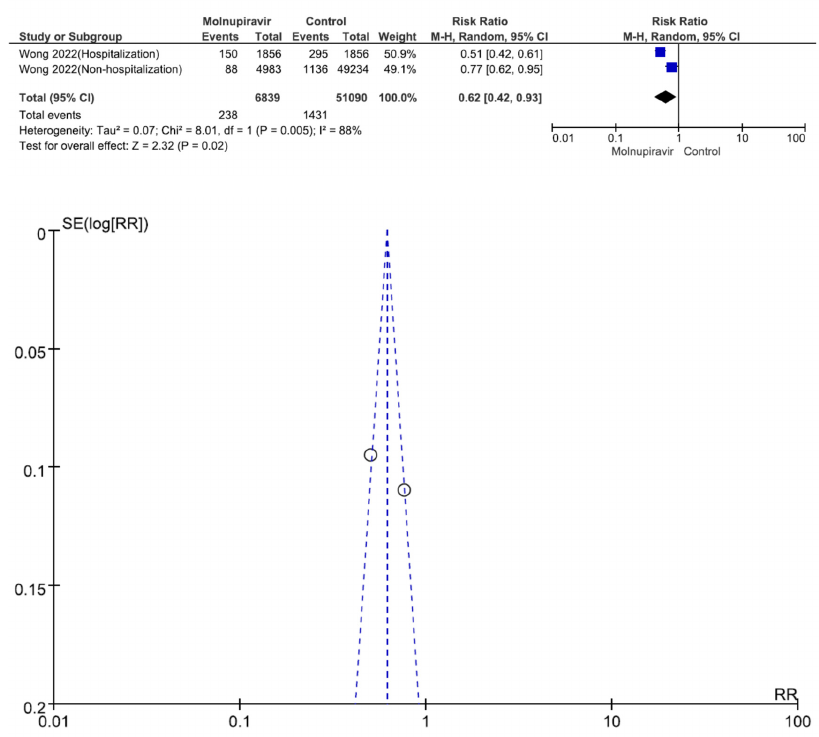
Antibiotics 2023 , 12 , x FOR PEER REVIEW Figure 5. All-cause mortality between molnupiravir and placebo in the treatment of mild to moderate COVID-19 in adult patients with low COVID-19 vaccination coverage [30,31]. Four studies involving 64,171 patients (9730 who received molnupiravir therapy, 54,441 who received placebo therapy) reported the composite outcome of disease progres- sion [28–31]. The composite outcome of disease progression was significantly different between molnupiravir-treated and placebo-treated patients (RR = 0.63, 95% CI = 0.57–0.71, p < 0.001, I 2 = 10%) (Figure 6).